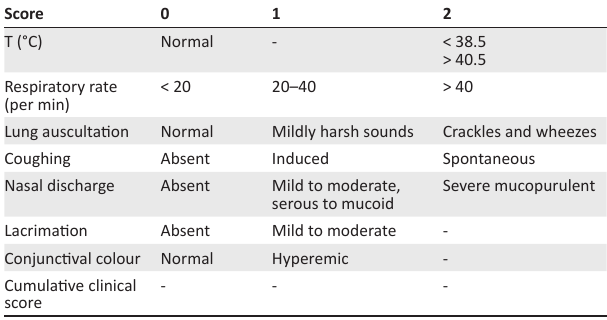
TABLE 1: Cumulative clinical scoring system used in the study. Score 0 1